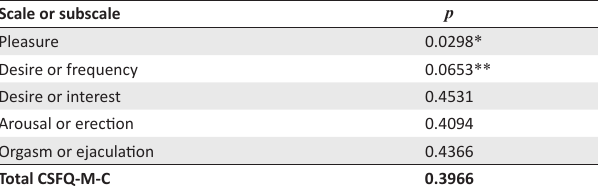
TABLE 3: Mann-Whitney U test p -values for testing whether the total CSFQ-M-C score and the subscale scores are significantly lower for participants on CPA than for participants not on